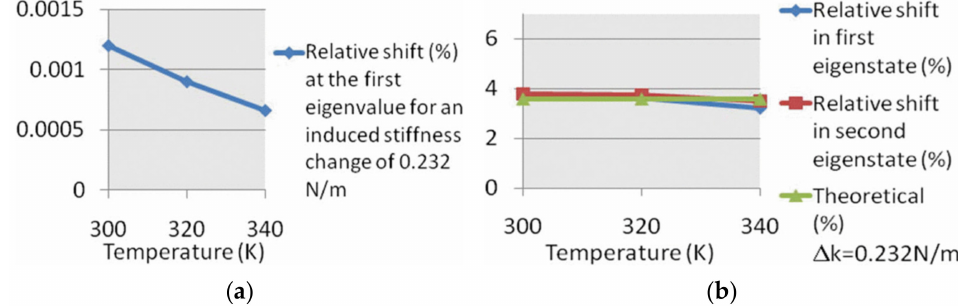
Figure 14. Effect of temperature change on the normalized sensitivity of resonators(Reprinted with permission from Ref. [83]). ( a ) 1-DoF resonators; ( b ) 2-DoF